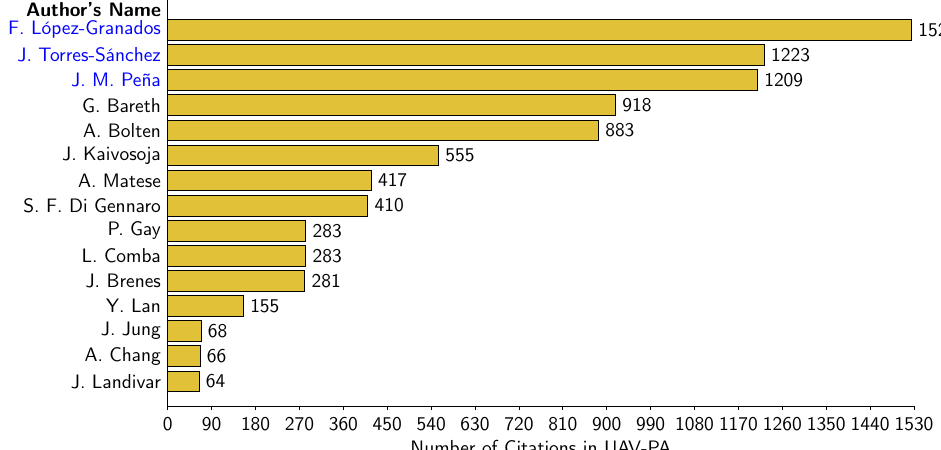
Figure 10. Most cited authors on adopting